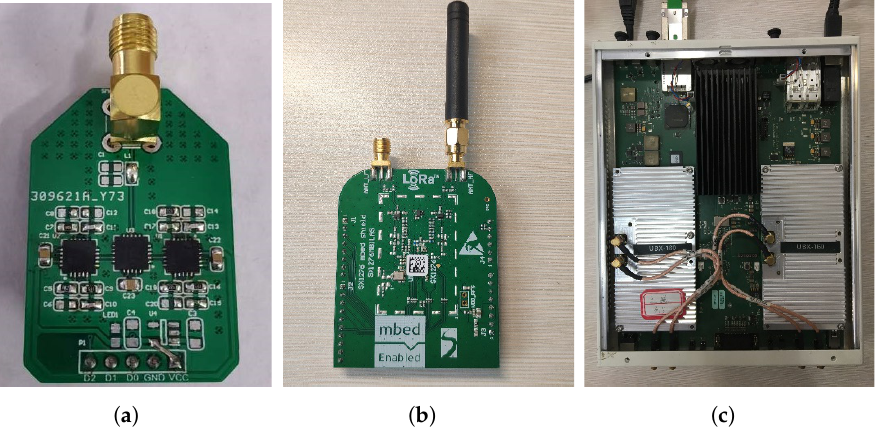
Figure 7. BackLoRa hardware and the test platform. ( a ) BackLoRa tag. ( b ) SX1276MBLAS LoRa transceiver. ( c ) USRP X310 with daughter board